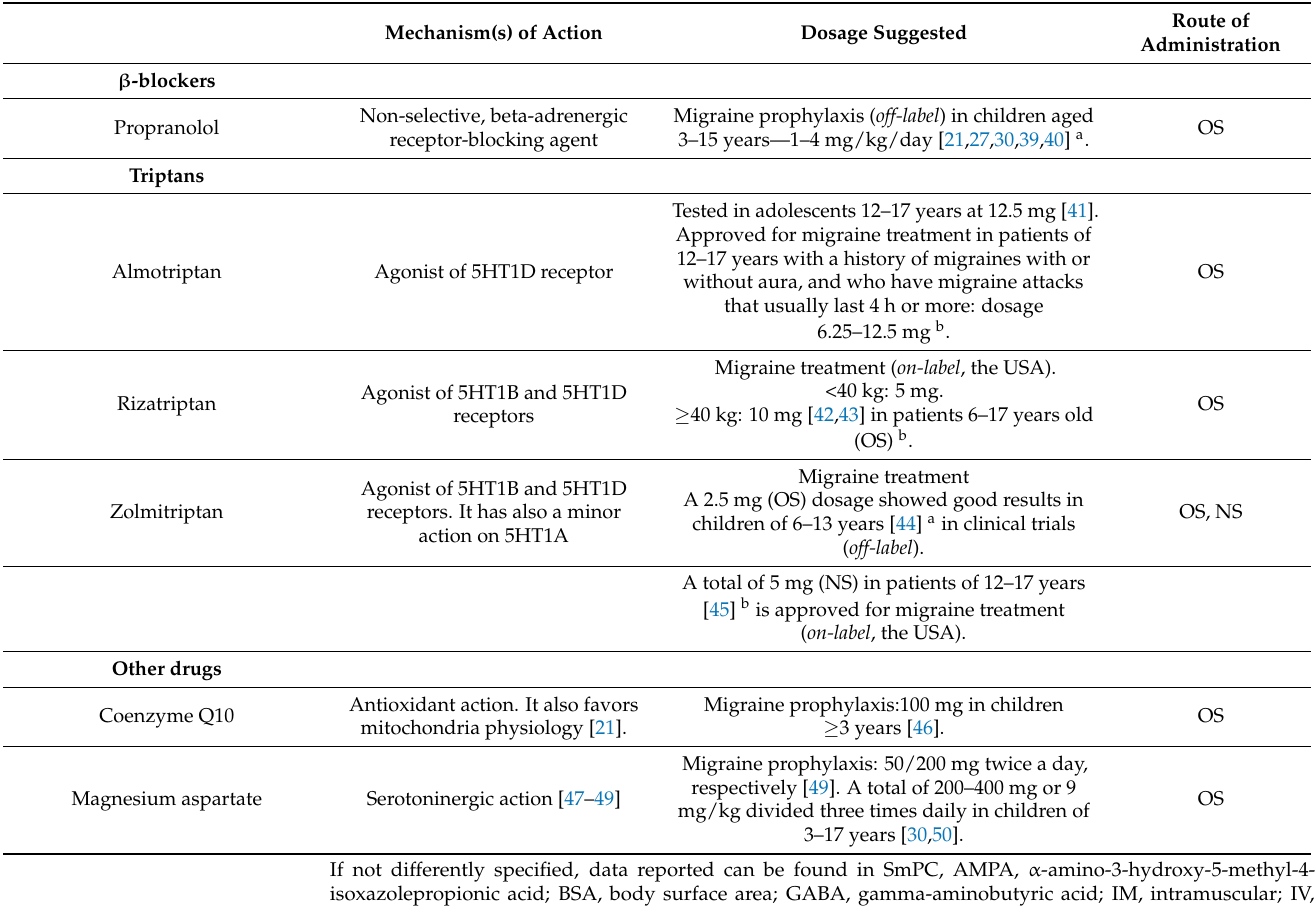
Table 2. Drugs used or evaluated for vestibular migraine and recurrent vertigo of childhood (off-label, part 2).